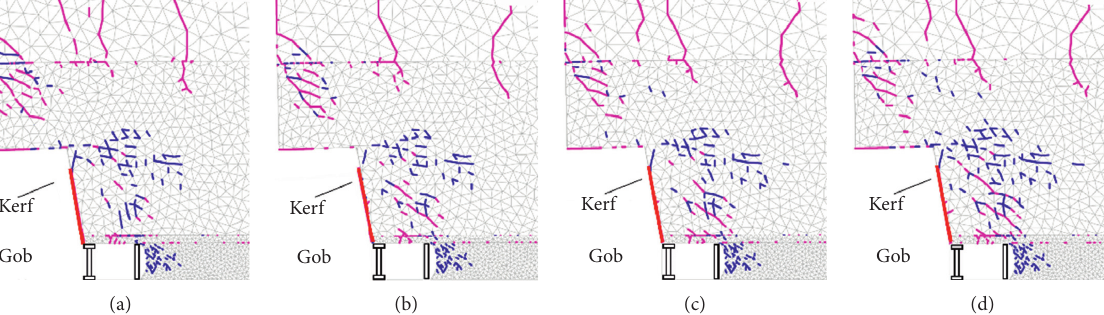
Figure 18: Simulation results of fracture development in surrounding rock for coal side support (the pink line represents the open cracks and the blue line stands for the slip cracks): (a) without lag, (b) with a 10000-step lag, (c) with a 20000-step lag, and (d) with a 30000-step lag.